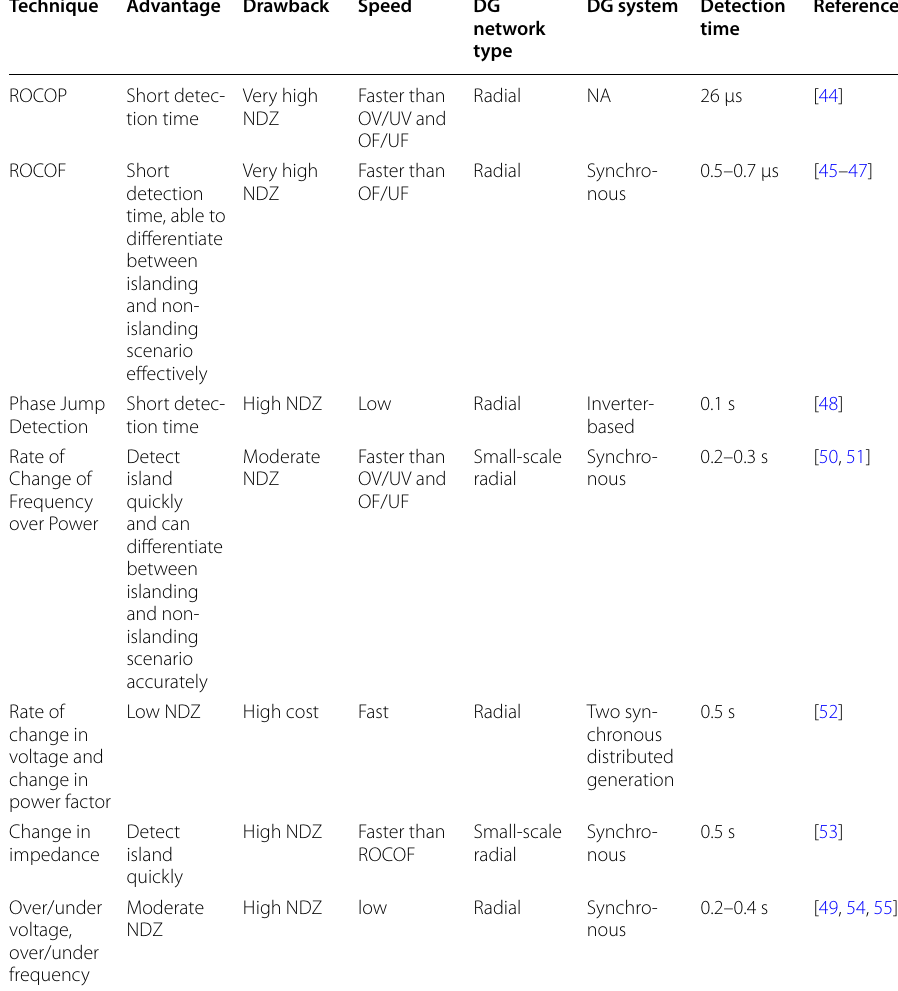
Table 2 Summary of various passive island detection technique